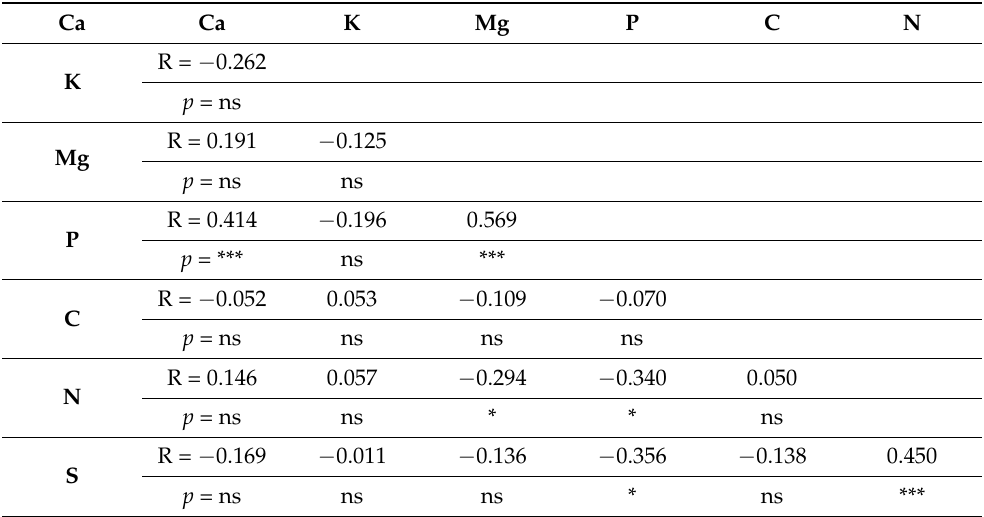
Table 5. Pearson correlation coefficients ( p and R values) between cottonseed minerals in cotton chromosome substitution lines (CS) grown in MS